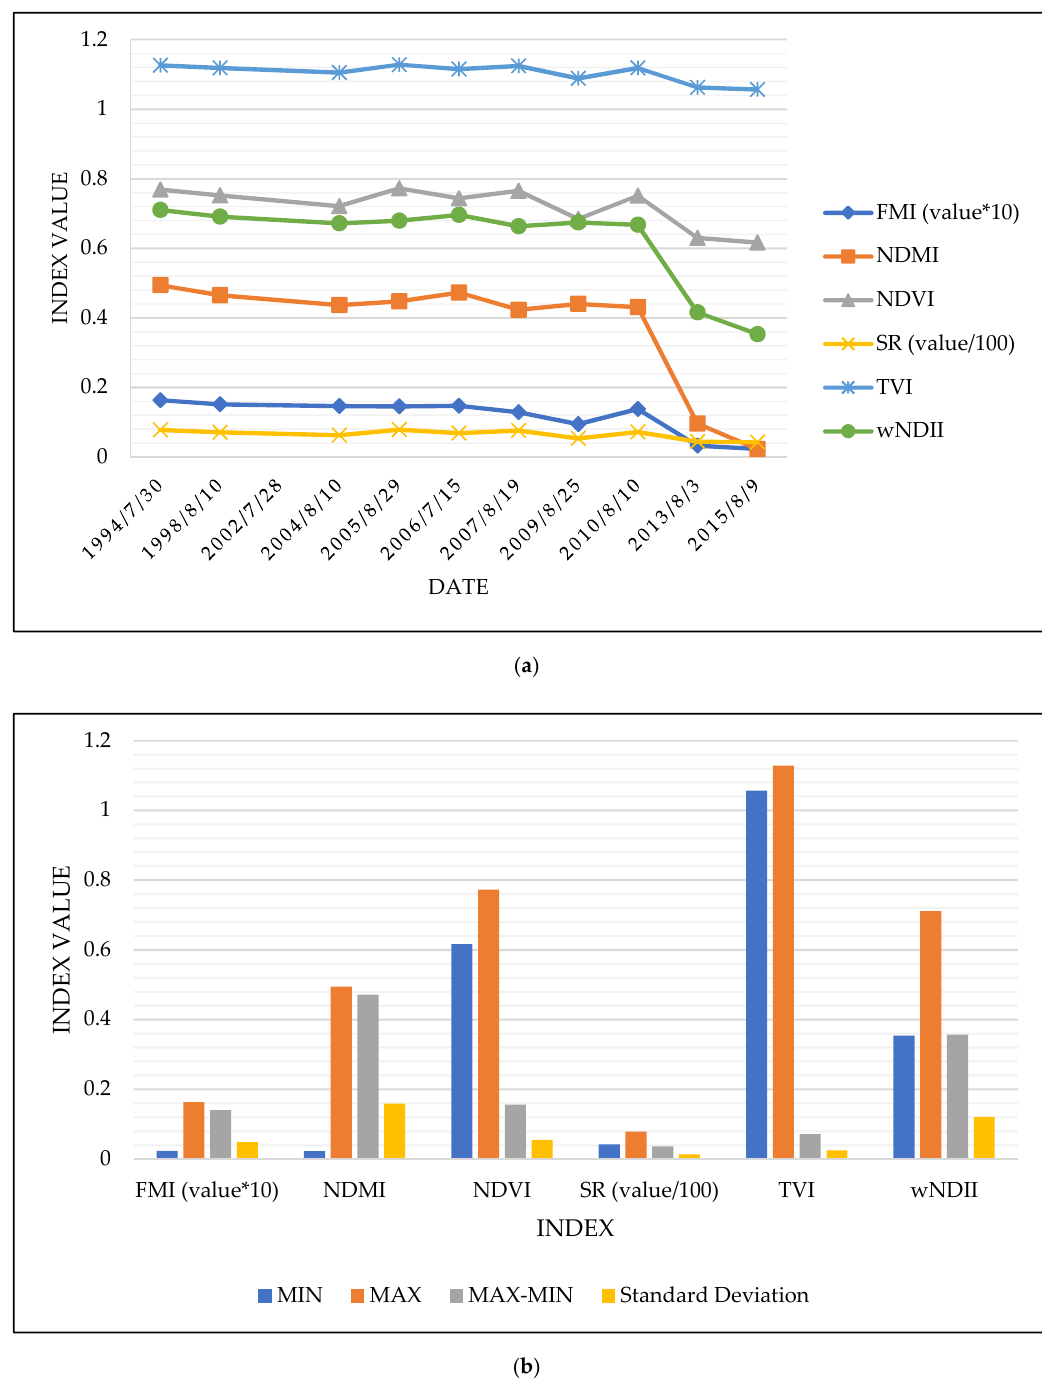
Figure 13. Time series of the vegetation indices for the area affected by the bark beetle ( a ); and the statistical information ( b ) (Locality 9) (Source: Own work).